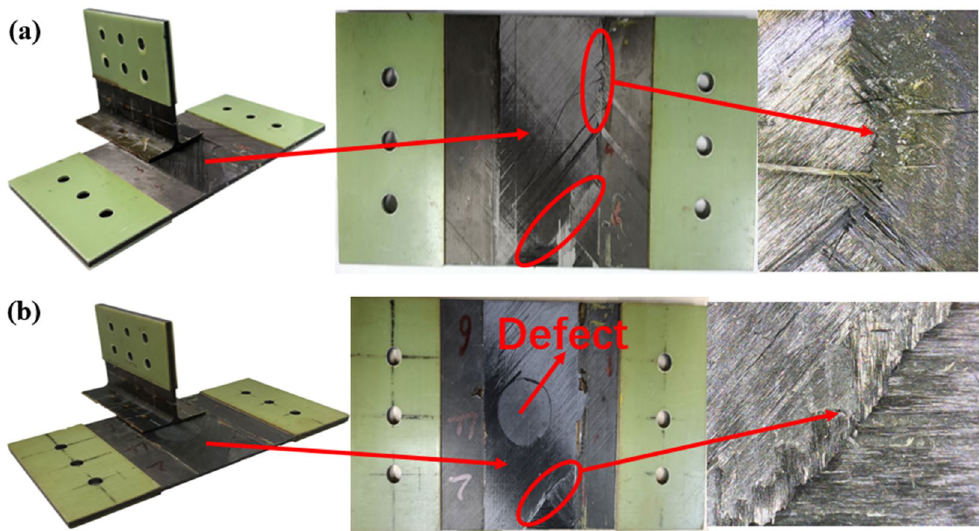
Figure 10. The results of the interface debonding test: ( a ) debonding appearance on side bending without defect; ( b ) debonding appearance on side bending with